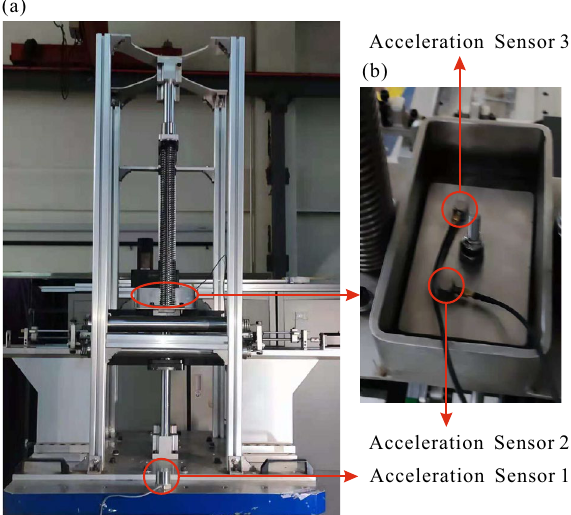
Figure 7. Experimental prototype and sensor layout scheme ( a ) for the panorama of the assembled prototype and the sensor layout scheme, ( b ) for the partial enlarged view of the loading